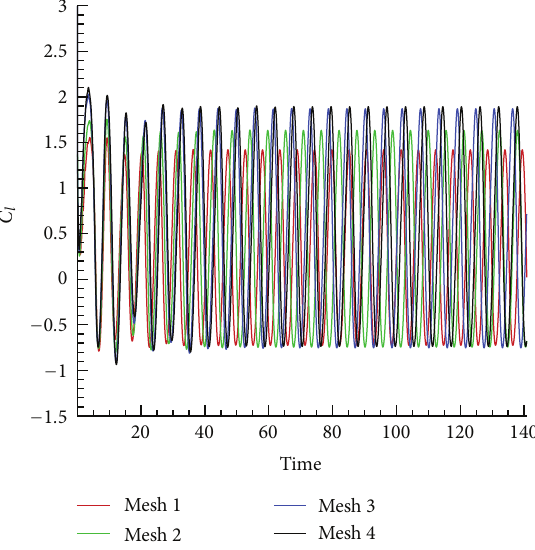
Figure 6: Grid sensitivity on lift coe ffi cient around the iced